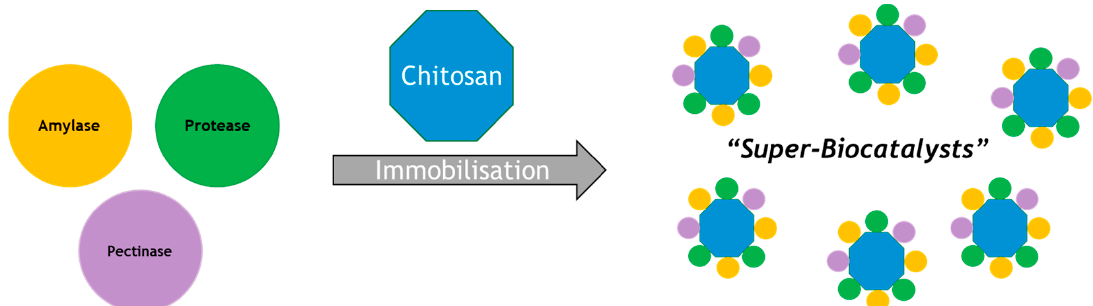
Figure 1. Immobilization studies using three enzymes to make “Super ‐ Biocatalysts”.